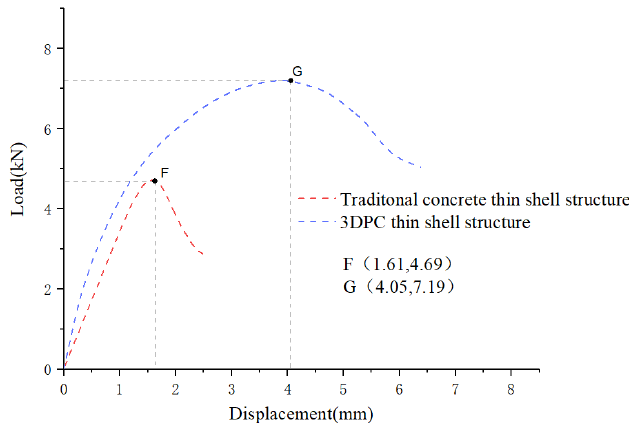
Figure 15. Load-displacement curve.